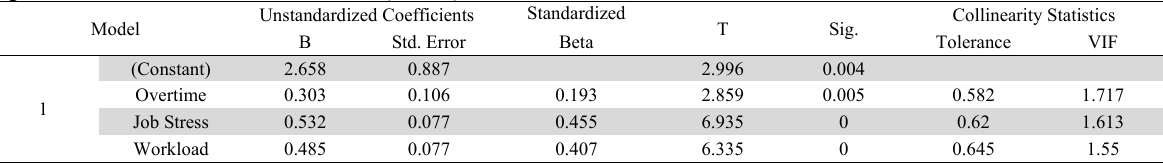
Collinearity Statistics T Sig.